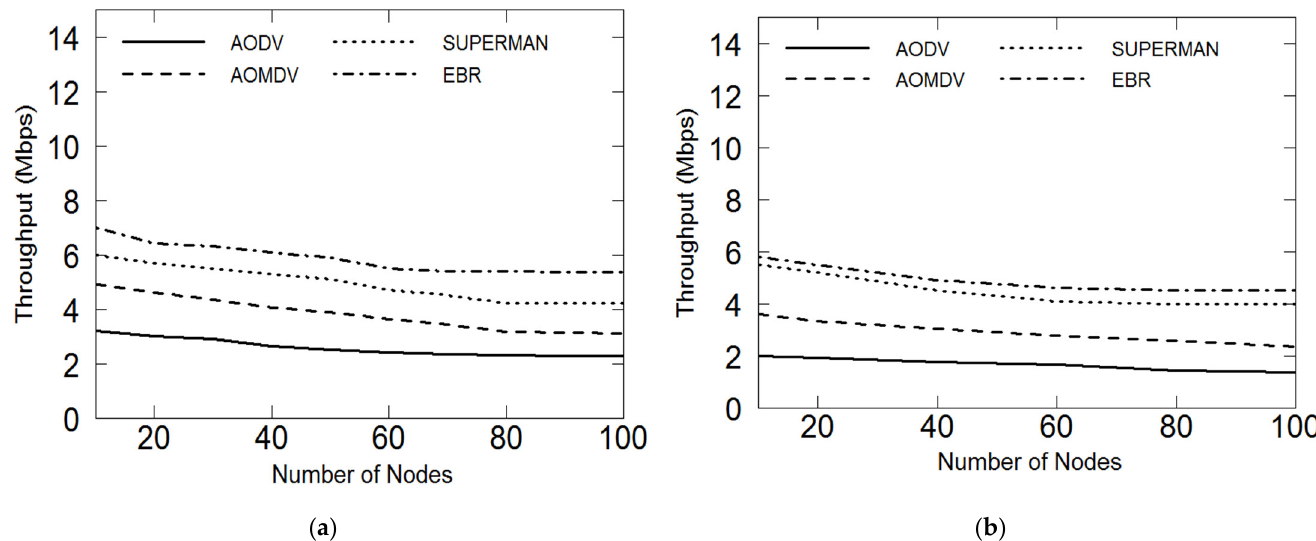
Figure 6 ( a ) Throughput vs. number of nodes (without attack); ( b ) Throughput vs. number of nodes (with attack).